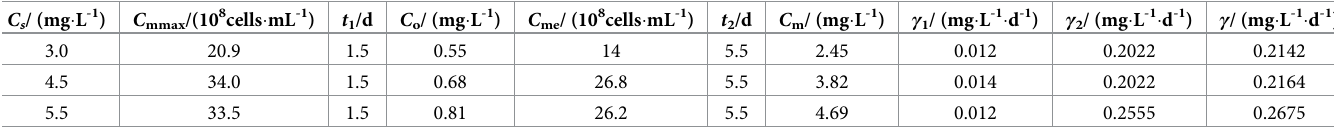
Table 5. The microbial experimental data processing and